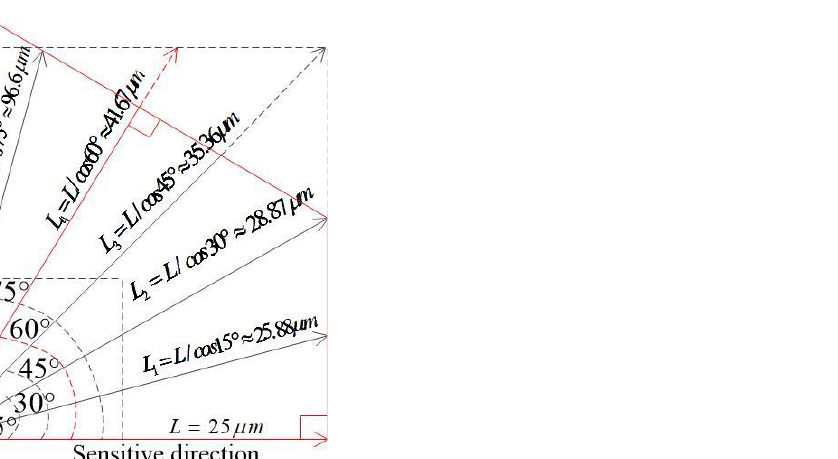
Figure 3. The schematic diagram of the displacement of proof mass when the direction of impact acceleration deviates from the sensitive direction of the inertial switch.